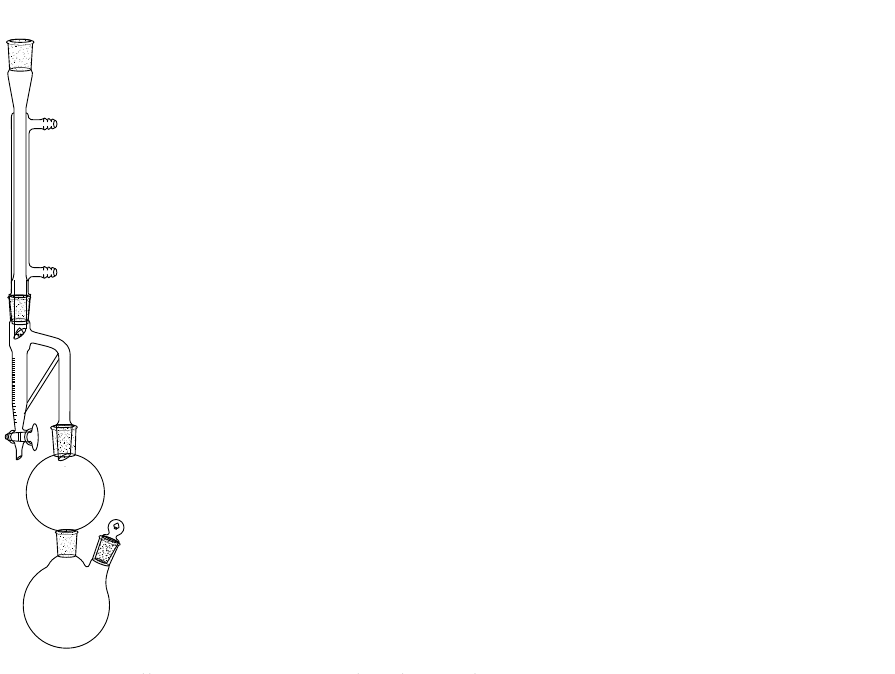
Figure 4. Distillation apparatus used in this study.